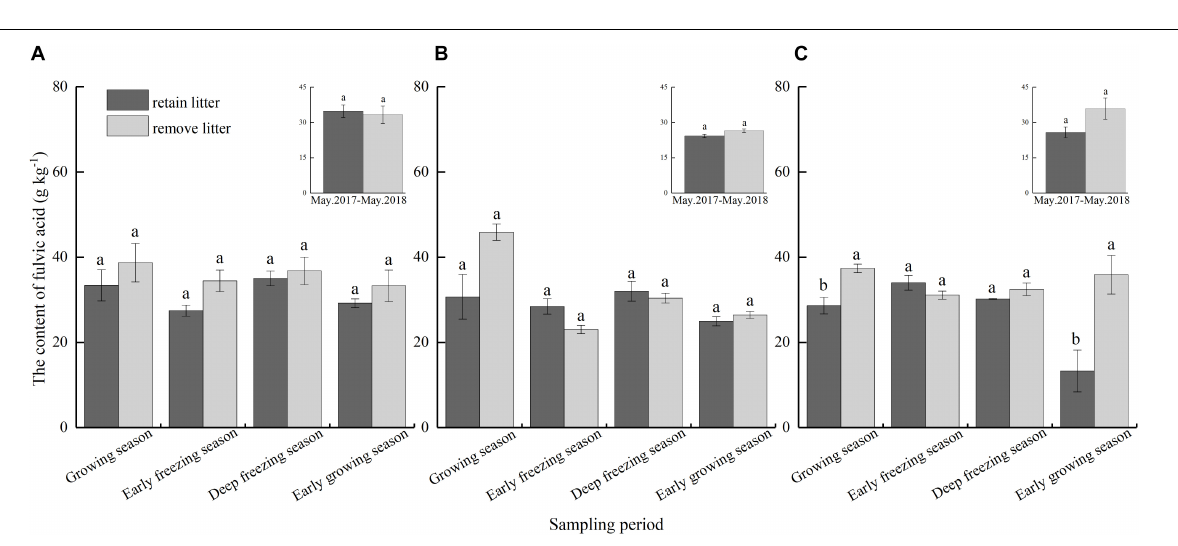
FIGURE 5 | Content of soil fulvic acid as affected by litter removal at different periods in the (A) coniferous forest, (B) mixed forest, and (C) broadleaved forest. The histograms show the averaged values over 1 year. The presented content values are the means of 3 observations; the error bars represent standard errors. Lowercase letters represent significant differences in the contents of total extracted humus between the different litterfall